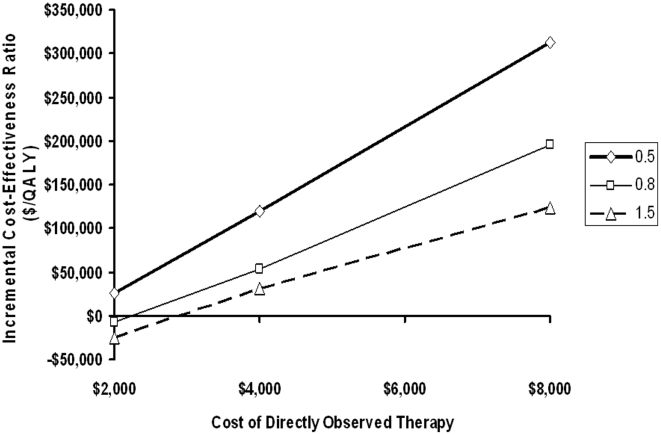
Two-Way Sensitivity Analysis on Effectiveness and Cost of Directly Observed Therapy.Each diagonal curve represents a different estimate of effectiveness (log10 reduction in viral load) of directly observed therapy: −0.5 log10 (thick line, squared); −0.8 log10 (thin solid line, diamonds); or −1.5 log10 (dashed line, triangles). Incremental cost-effectiveness of directly observed therapy relative to self-administered antiretrovirals appears on the Y-axis. At each level of effectiveness, increasing the cost of directly observed therapy increases the cost-effectiveness ratio associated with this intervention; however, only under the most unfavorable cost and effectiveness assumptions does this ratio exceed $50,000 per quality-adjusted life-year (QALY) gained, a commonly cited cost-effectiveness threshold (horizontal dashed line). Values falling below the X-axis indicate that directly observed therapy is cost-saving.